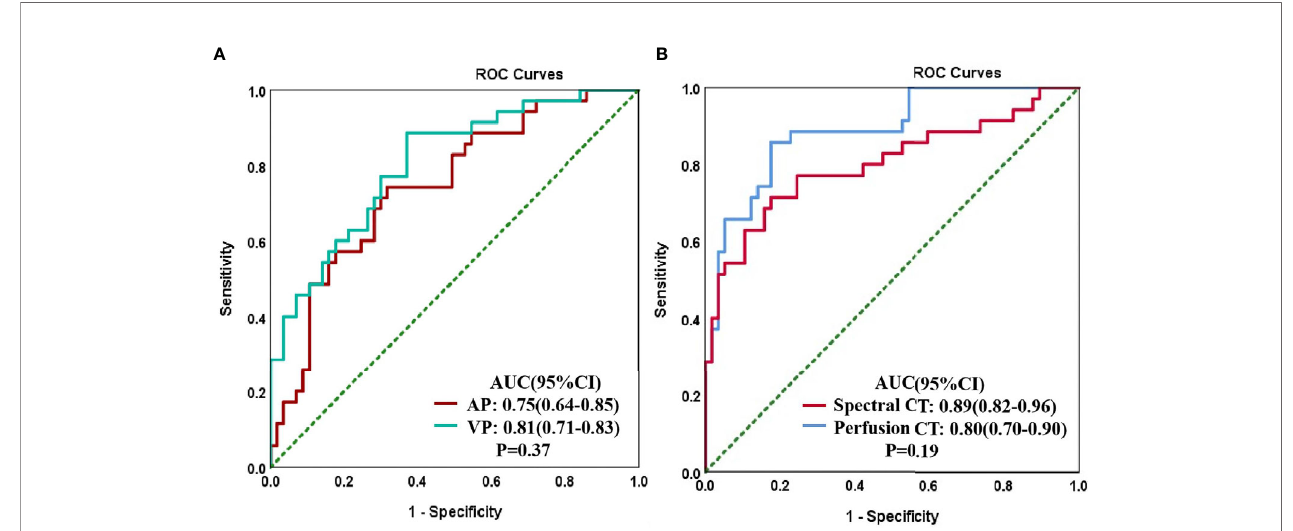
FIGURE 4 | Receiver operating characteristic (ROC) curves for CT spectral parameters in arterial (AP) and venous (VP) phases in the peripheral lung cancer (PLC) and focal organizing pneumonia (FOP) groups (A) . The ROC curves of spectral and perfusion imaging for the PLC and FOP groups (B)